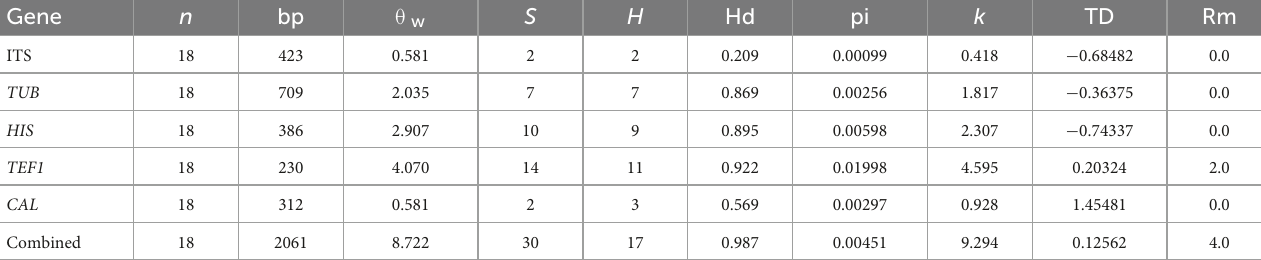
TABLE 3 Polymorphism and genetic diversity parameters of Diaporthe atlantica strains associated with Festuca rubra subsp. pruinosa